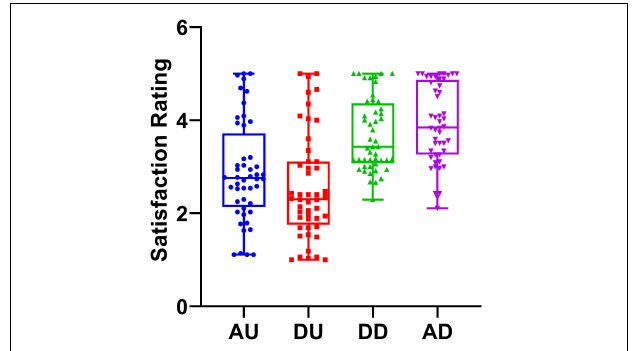
FIGURE 4 | Satisfaction rating under various feedback conditions. Advantageous upward condition is shown in blue; disadvantageous upward condition is shown in red; disadvantageous downward condition is shown in green; and advantageous downward condition is shown in